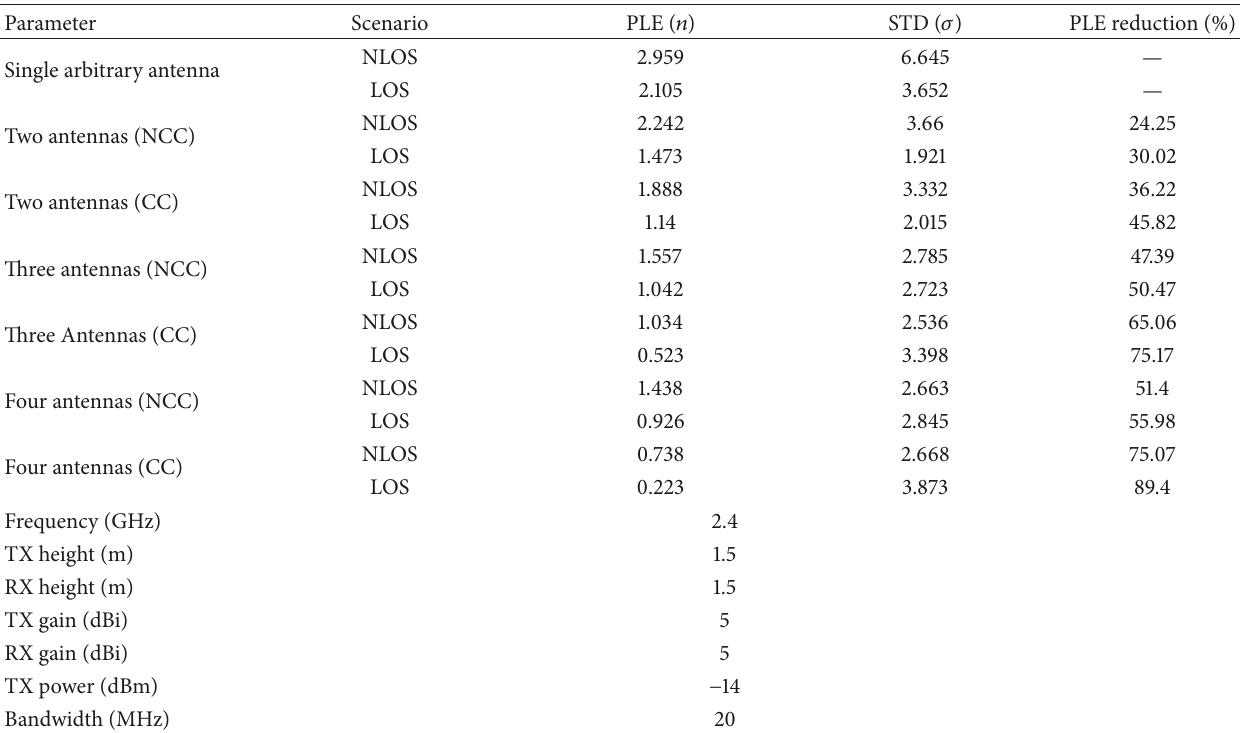
Table 1: LDM parameters for SISO and SIMO cases using NCC and CC schemes when considering the LOS and NLOS scenarios along with the respective PLE